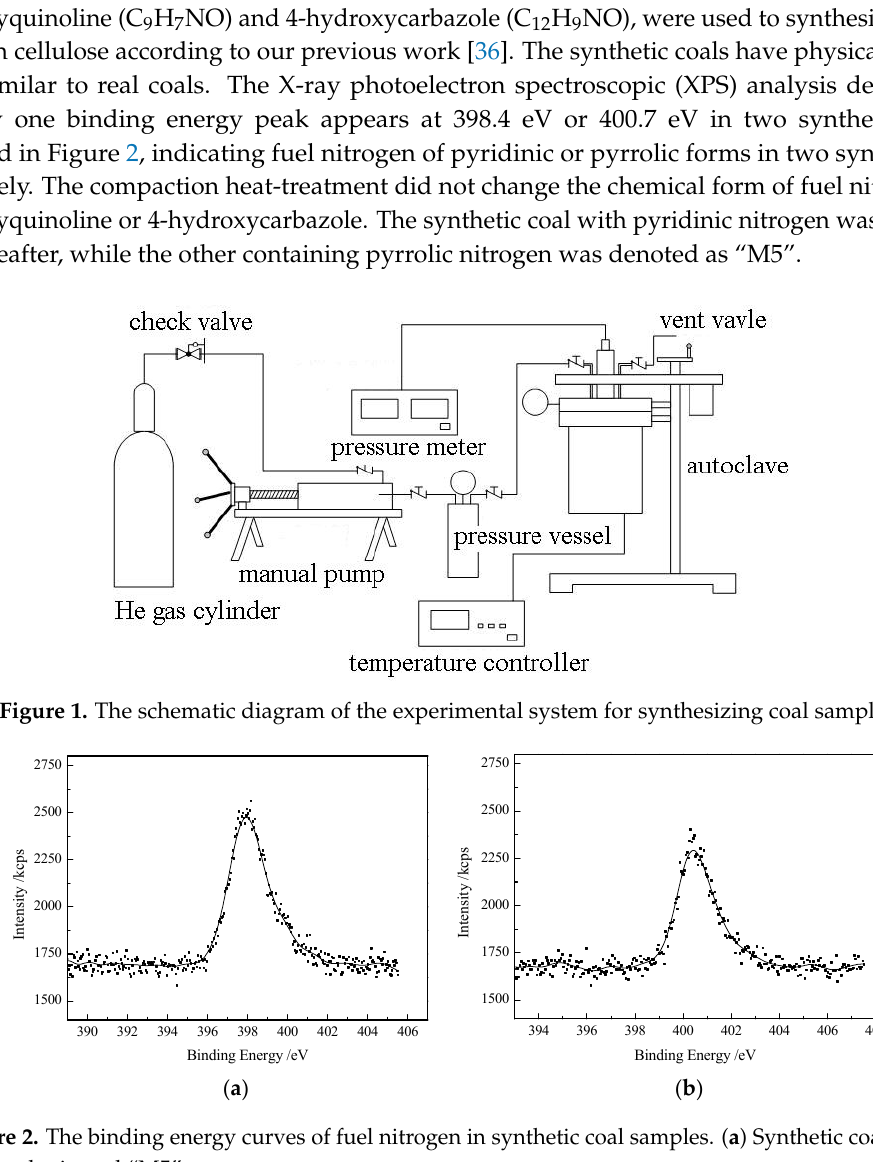
Figure 2. The binding energy curves of fuel nitrogen in synthetic coal samples. ( a ) Synthetic coal “M6”; ( b ) Synthetic coal “M5”.